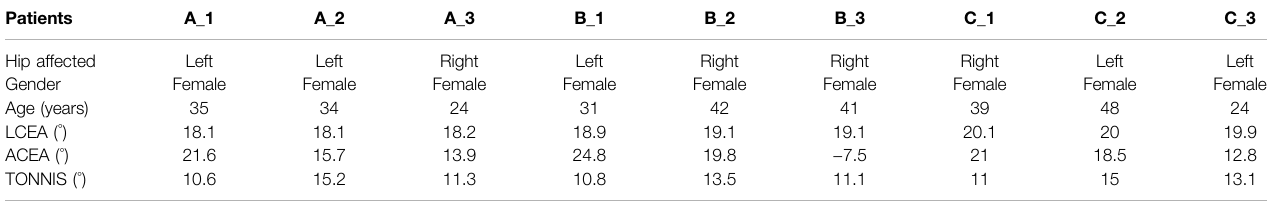
TABLE 1 | Clinical data of patients with borderline developmental dysplasia of the hip. Patients